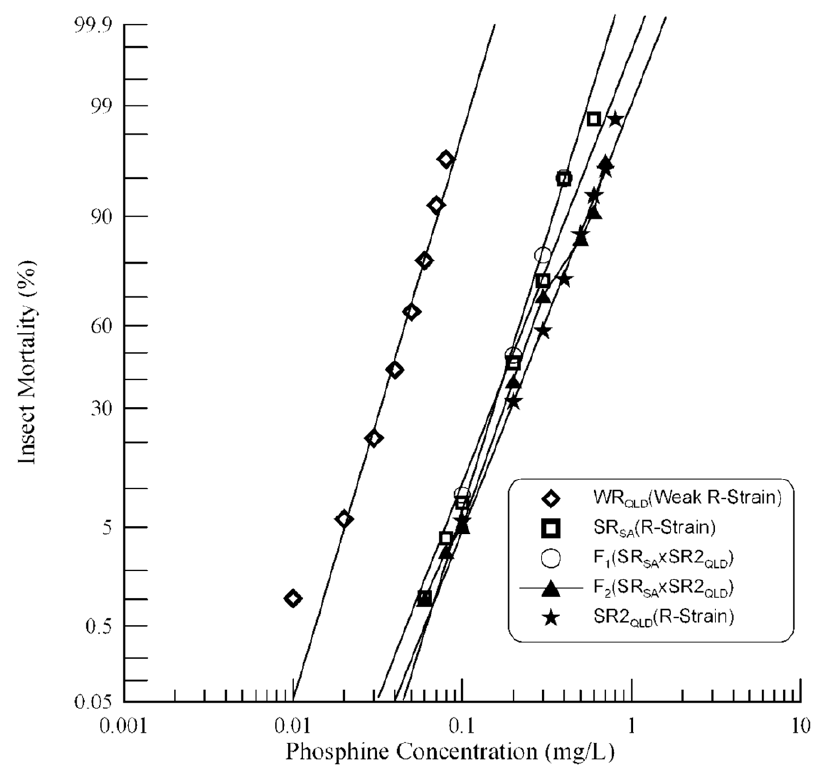
Figure 7. Resistance response of F 1 hybrids and F 2 progeny of a cross between strongly resistant R. dominica strains from Queensland and South Australia. Results are presented as log-dose mortality of the F 1 hybrids and the F 2 progeny with reference curves of the parental strains, SR2 QLD and SR SA , and the weakly resistant strain from Queensland (WR QLD ). Phosphine exposure was for 48 hours at 25 u C and 70% r.h.